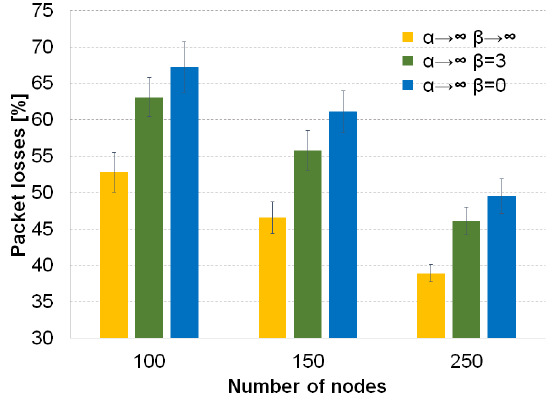
Figure 5. Percentage of packet losses for different values of the recovery factor β , using the best node criterion at the forwarding phase without